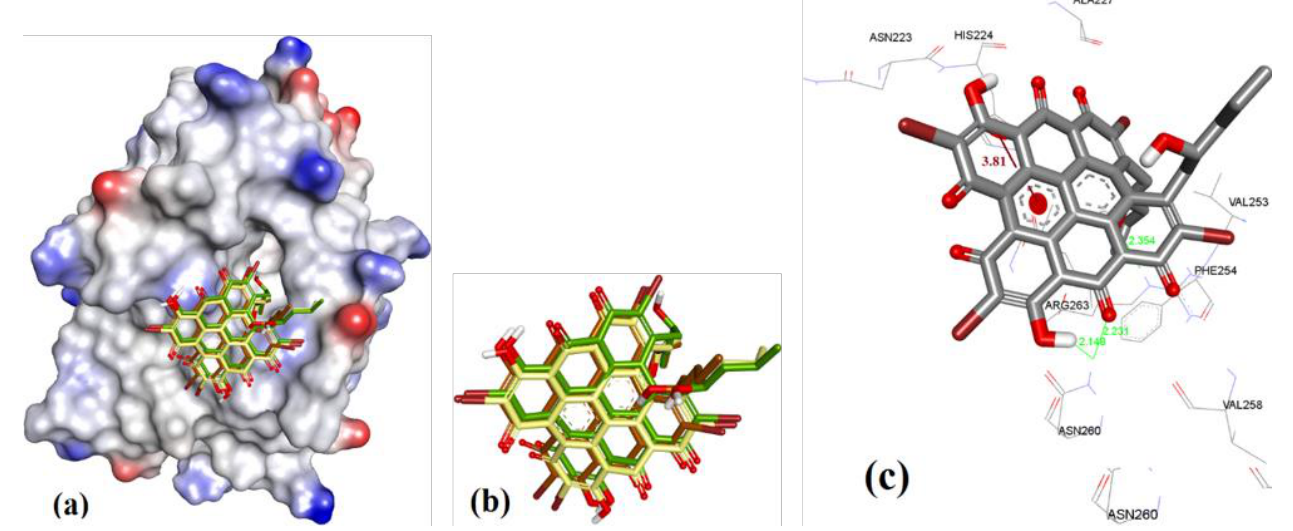
Figure 6. ( a ) The ionized solvent-exposed surface mapping of hMcl-1 along with the docked poses of Gymnochrome-F from MOE (in brown), AutoDock (in green), and VlifeDock (in yellow) show their fitting to the cavity, and all are within 1.08 Å RMSD. ( b ) Similar-pose ensemble clustering of all three poses was attained from the three different docking methods. ( c ) Binding mode of Gymnochrome-F with hMcl-1.